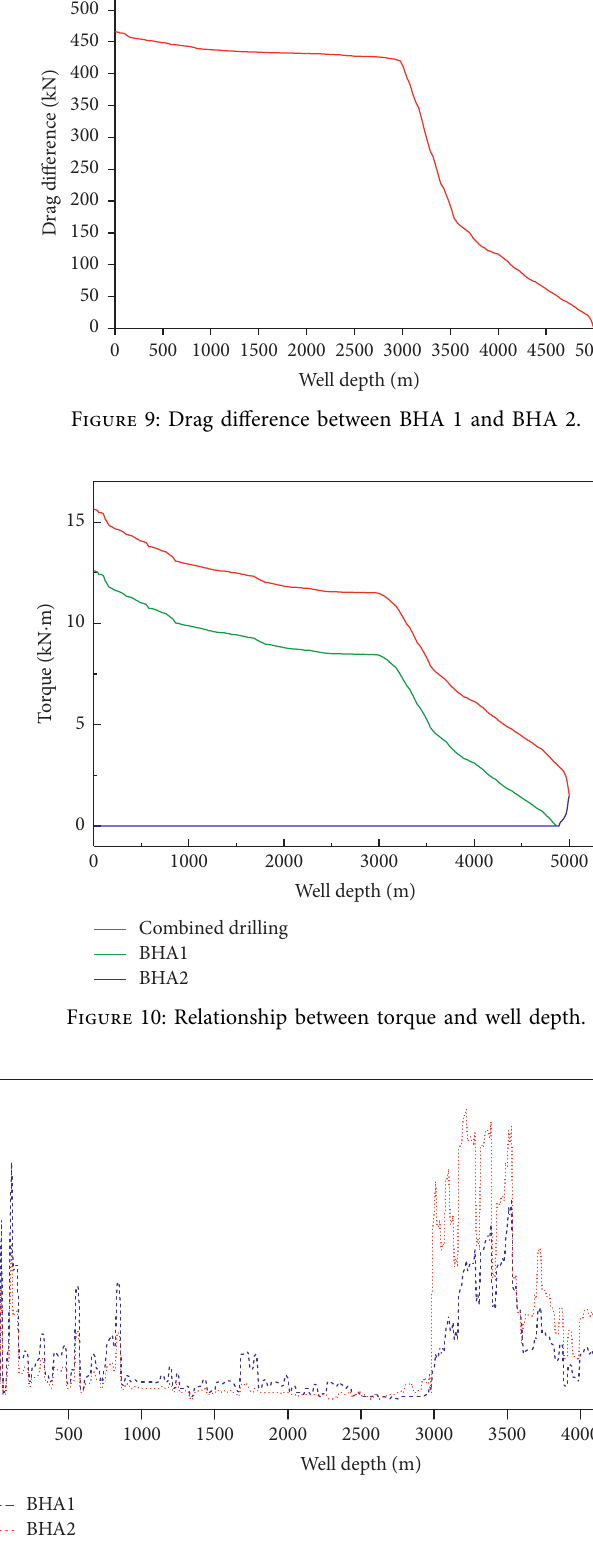
Figure 11: Distribution of friction force with and without